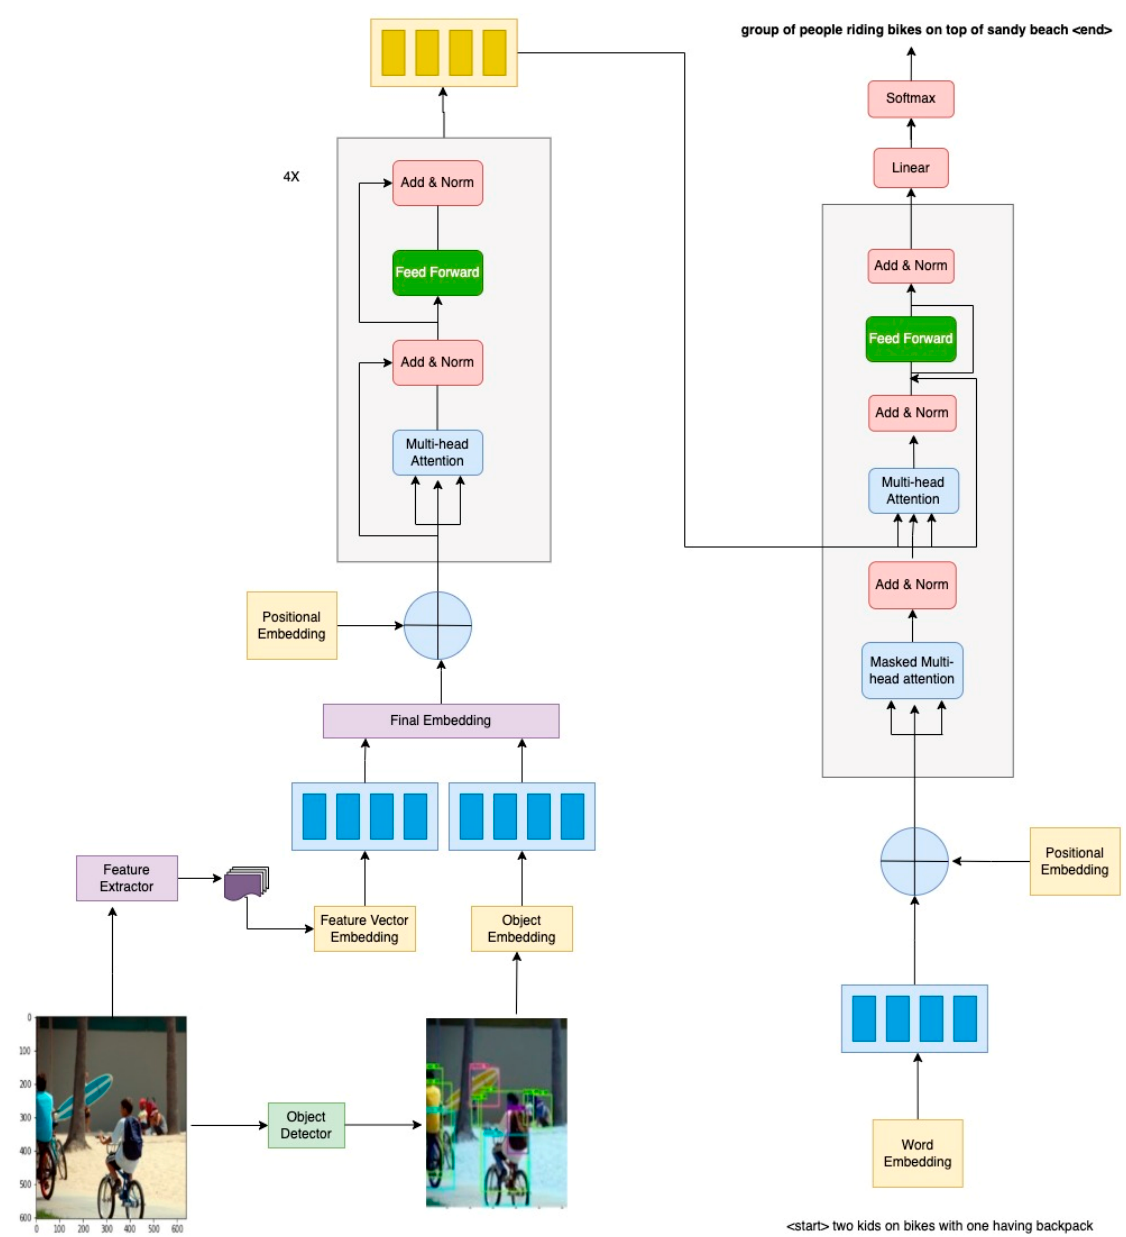
Figure 3. Architecture of the transformer used for image captioning.